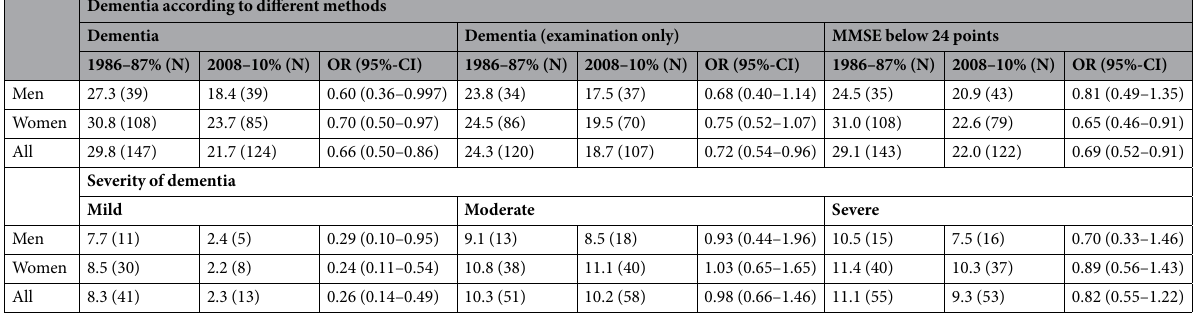
Table 2. The prevalence of dementia and its severity in 85-year-olds examined in 1986–87 and 2008–10. Note: Mini Mental State Examination (MMSE) was only done in 491 individuals in 1986–87. The sample examined in 1986–87 is reference group for all odds ratio